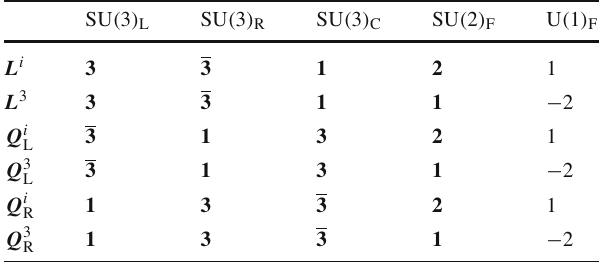
Table 5 Quantum numbers of the components of the adjoint chiral superfield ( 78 , 1 ( 0 ) ) with respect to various